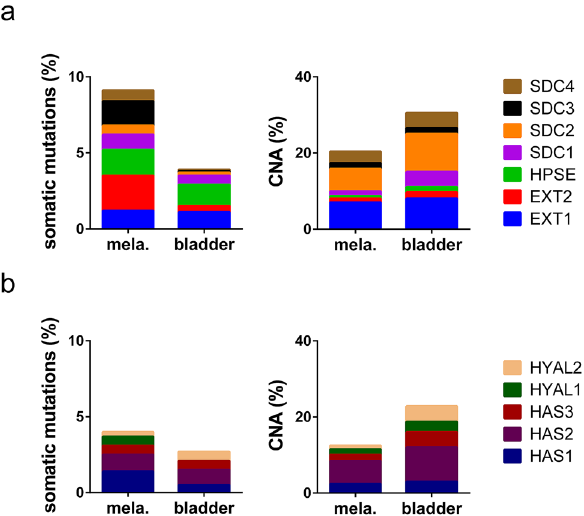
Figure 1. Genetic alterations in glycocalyx-related genes. ( a , b ) Screening of public exome sequencing data indicate somatic mutations and copy number alterations (CNAs) in tissues of melanoma (mela.) and bladder cancer (bladder). ( a ) Shown are the percentages of patients with genetic alterations in the proteoglycans syndecan 1 ( SDC1 ), SDC2 , SDC3 and SDC4 , the heparan sulphate degrading heparanase ( HPSE ), exostosin glycosyltransferase 1 ( EXT1 ) and EXT2. ( b ) Shown are the percentages of patients with genetic alterations in hyaluronidase 1 (HYAL1) and HYAL2 and hyaluronan synthases (HAS1) , HAS2 and HAS3